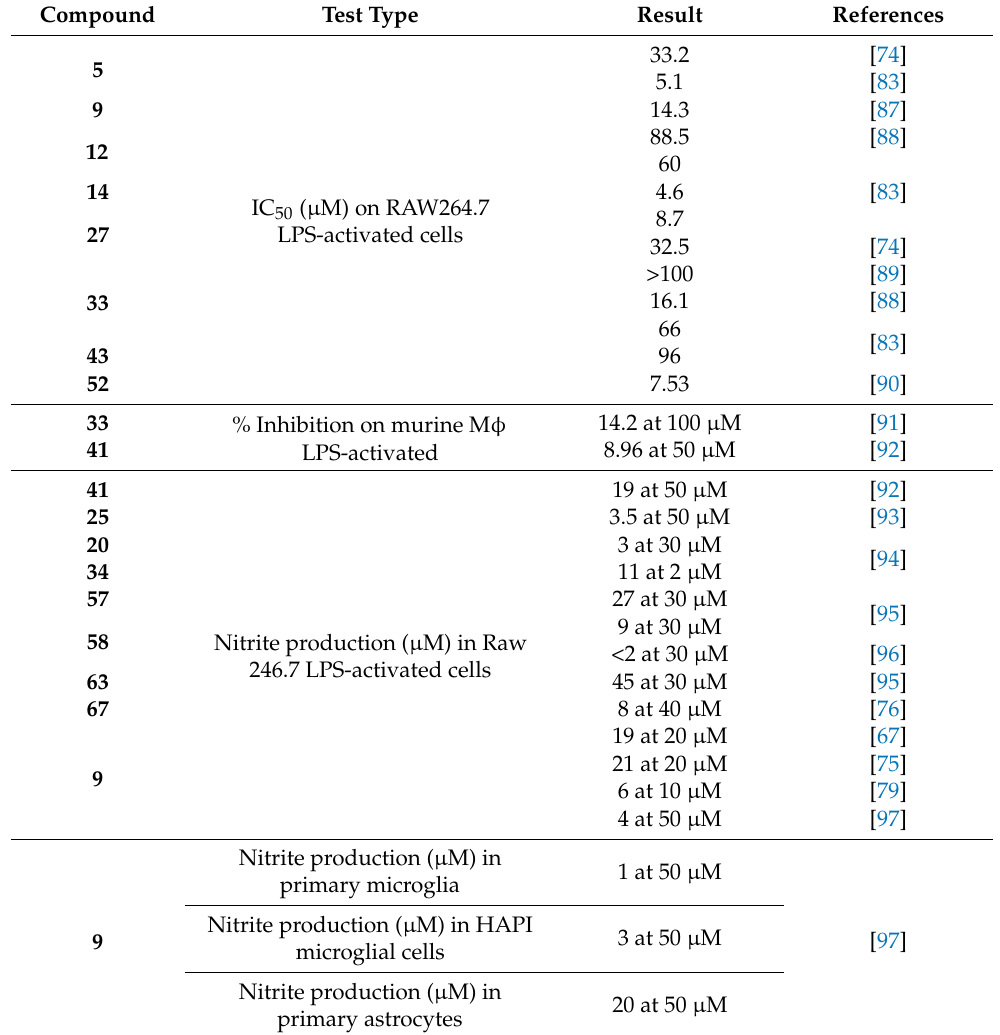
Table 7. Inhibition of NO